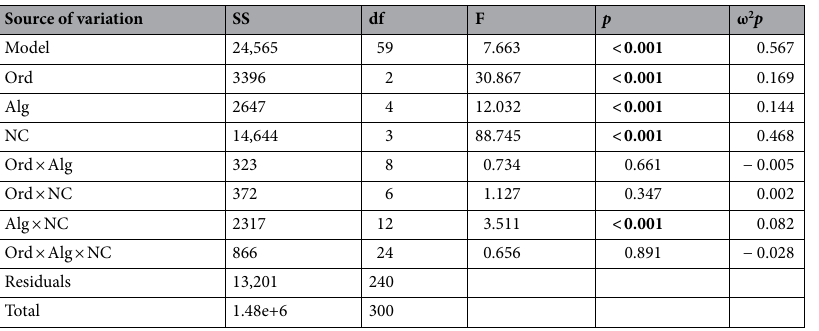
Table 1. Summary of GLM performed with overall accuracies erosion as target variable. Ord dimension reduction type, Alg classification algorithms, NC number of components, SS Sum of Squares, df degree of freedom, F F-statistic, p significance, ω 2 p effect size; × : statistical interactions. p < 0.001 is highlighted with bold.